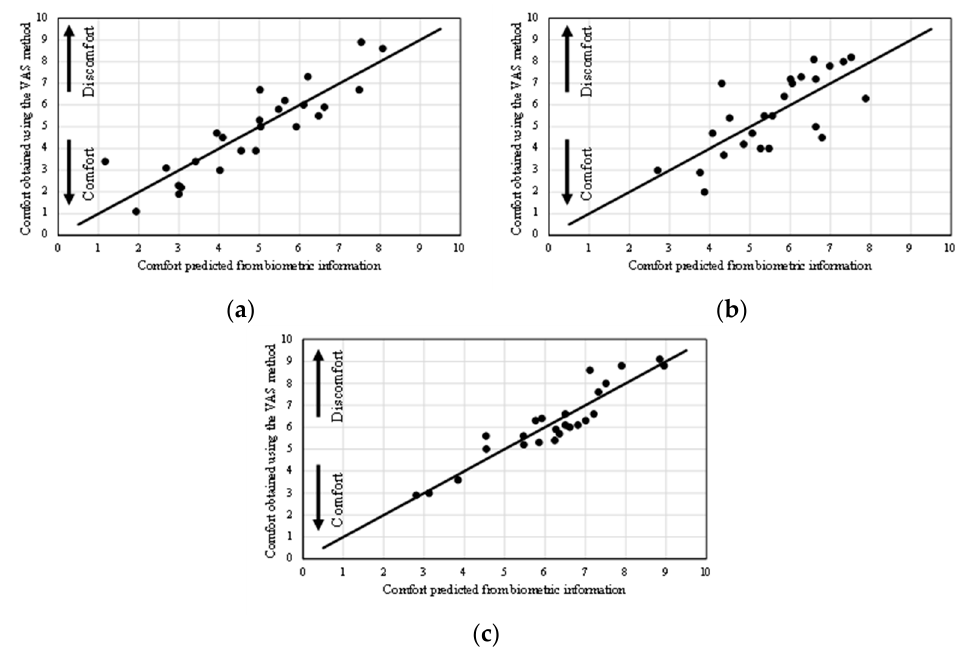
Figure 9. Results of multiple regression analysis. ( a ) 0.2–3 Hz; ( b ) 4–8 Hz; ( c ) 8–20